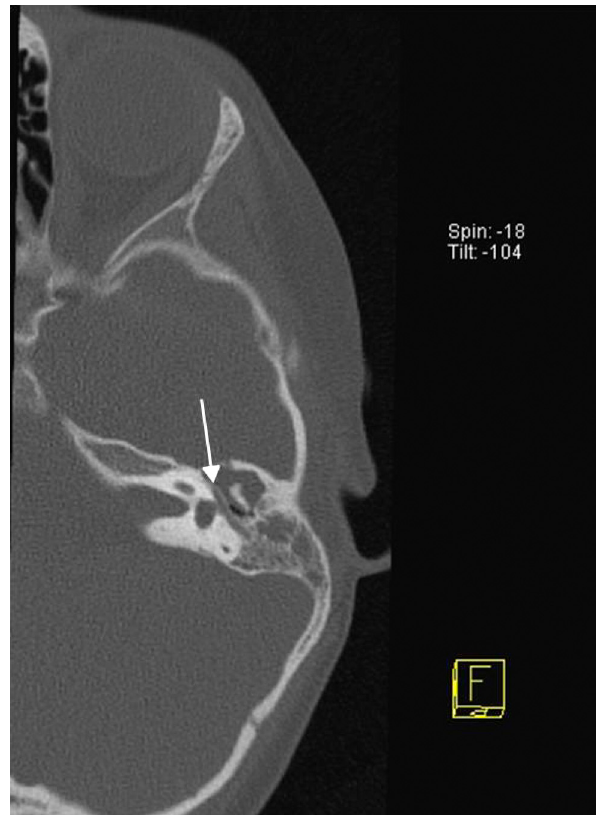
Axial MDCT scan of the left temporal bone at the level of the horizontal portion of the facial nerve (arrow), show- ing the soft tissue mass in the attic and antrum.